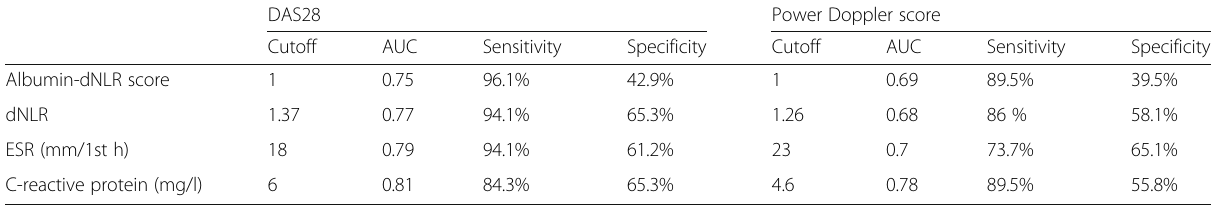
Table 3 Receiver operating characteristic (ROC) curve for the performance of dNLR, albumin-dNLR score, ESR, and CRP in predicting DAS28 and power Doppler score in rheumatoid arthritis patients